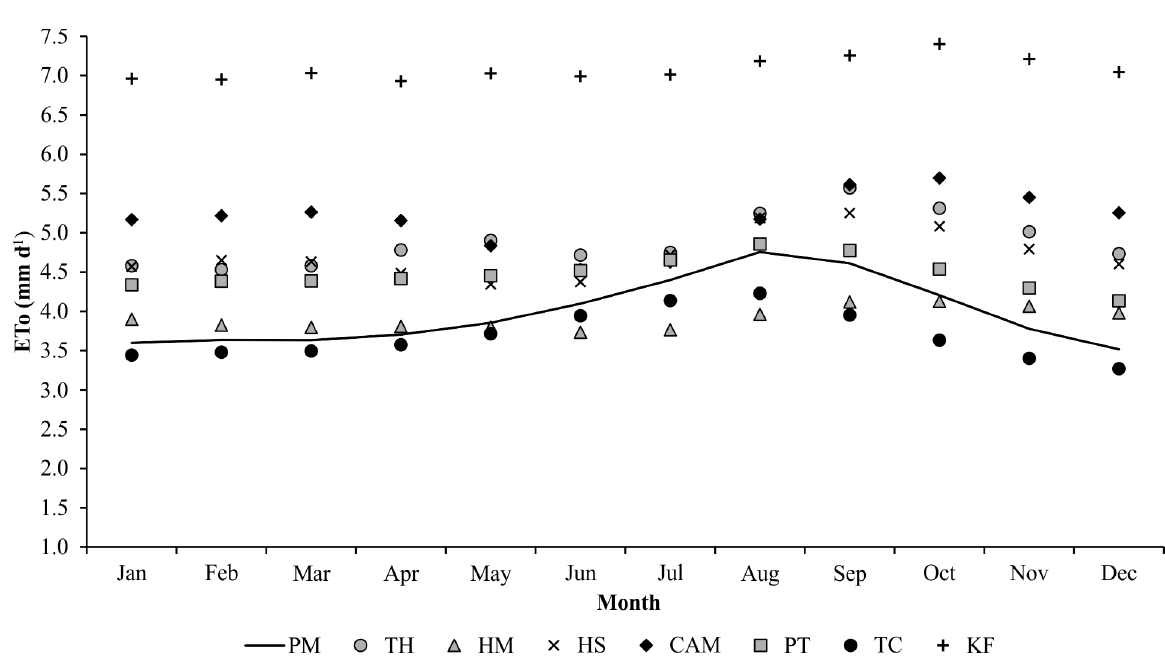
Figure 3 - Mean monthly ETo values for the Marabá station, in mm.d -1 , for 1980–2013. The continuous line indicates the FAO Penman-Monteith method (PM-FAO56); TH = Tornthwaite; HM = Hamon; HS = Hargreaves-Samani; CAM = Camargo; PT = Priestley-Taylor; TC = Turc; KF =